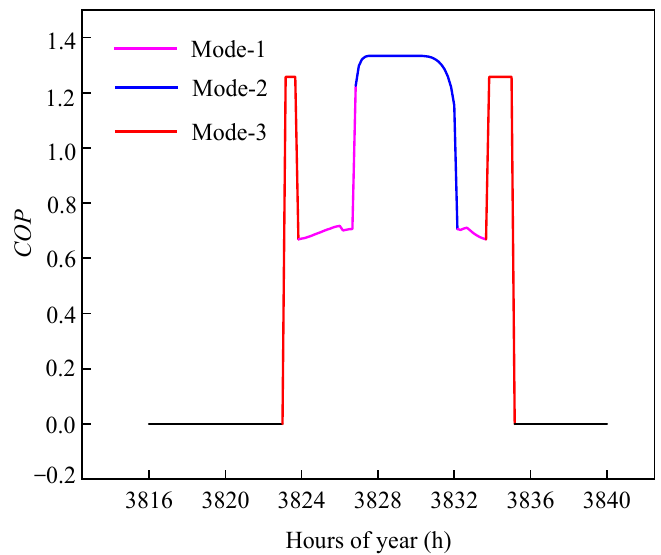
Figure 7. Variation of COP of chiller on the second day of simulation.